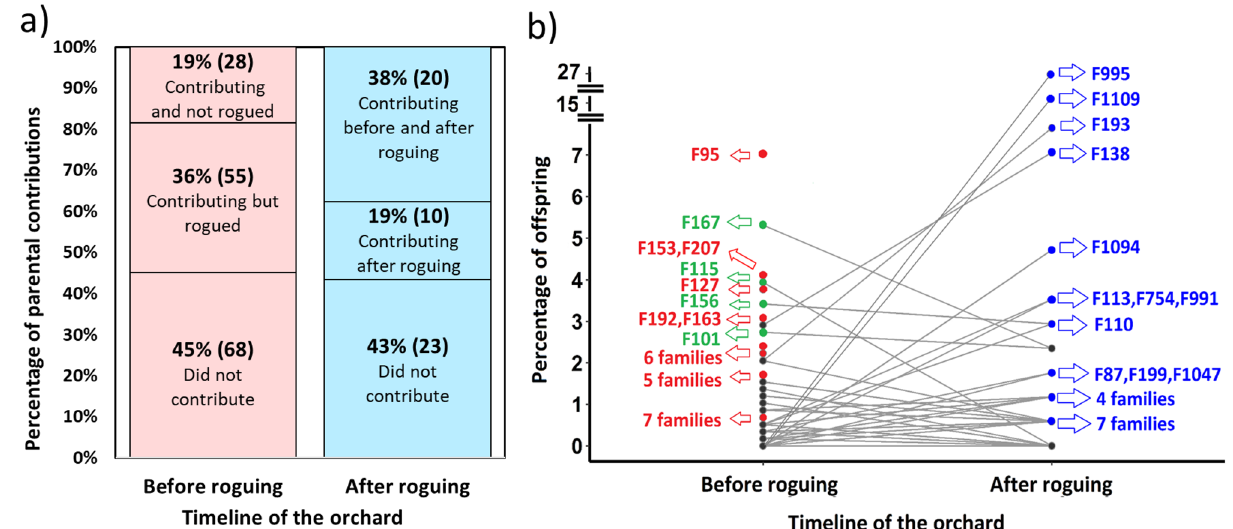
Figure 3. Changes in parental contributions before and after roguing the G1 white spruce clonal seed orchard estimated with pedigree reconstruction using genomic profiles with a set of 2000 SNPs. ( a ) Stacked bar chart (100% baseline) showing changes in parental contributions influenced by genotype roguing; ( b ) Rank-order line chart showing changes in specific genotype contributions (100% baseline), with some genotypes contributing and others eliminated from the G1 clonal seed orchard (red dots), some genotypes decreasing their contribution after roguing the clonal seed orchard (green dots) while other genotypes increasing their contribution after roguing (blue dots). Calculations before roguing were based on 420 seedlings and 151 parents, and calculations after roguing were based on 105 seedlings and 53